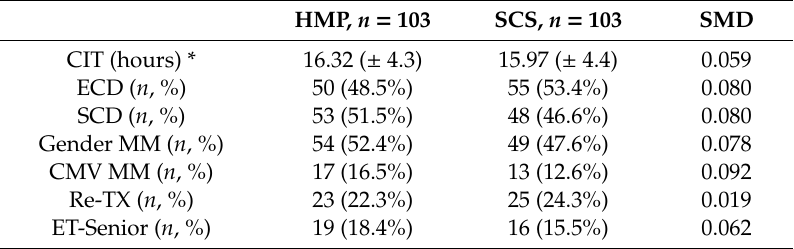
Table 3. Donor and recipient demographics and transplant factors stratified by HMP and